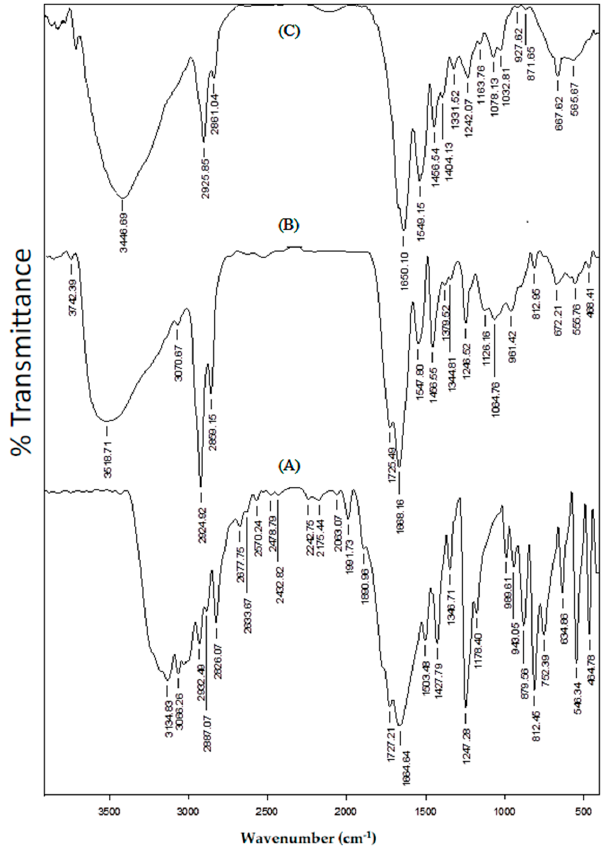
Figure 2. FTIR spectra of (A) 5-FU, (B) 5-FU-laded blend hydrogel microspheres, and (C) placeboblend hydrogel microspheres.